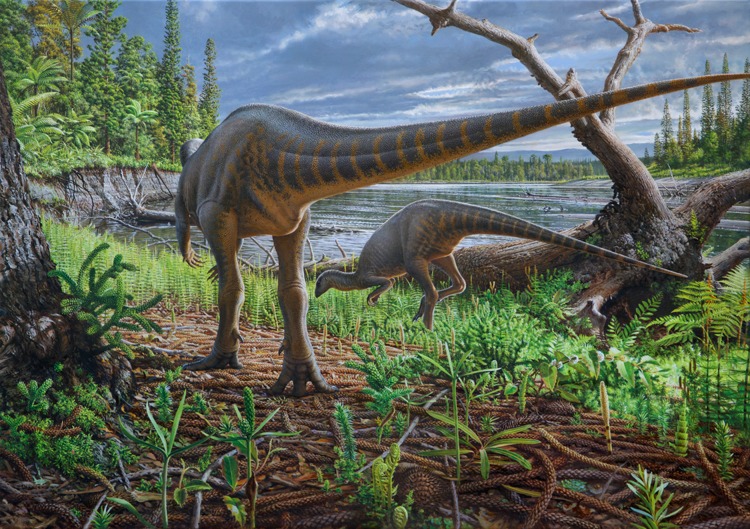
Artist’s interpretation of the early Albian, volcaniclastic, floodplain palaeoenvironment within the Australian-Antarctic rift graben, in the region of Eric the Red West.Scene depicting two individuals of Diluvicursor pickeringi on the cutbank of a high-energy meandering river, regional floral components and distant rift margin uplands. Floral components potentially included forest trees of Araucariaceae (Agathis and Araucaria), Podocarpaceae and Cupressaceae and lower story/ground cover plants, including pteridophytes (ferns, including equisetaleans), hepatics, lycopods, cycadophytes, bennettitaleans, seed-bearing fern- or cycad-like taeniopterids and early Australian angiosperms. Artwork by P. Trusler, with permission.